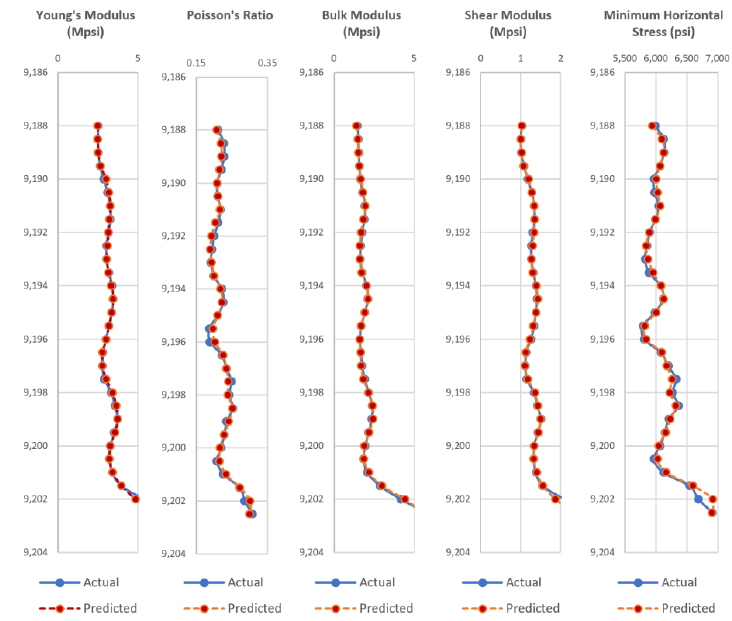
Figure A1. Actual and predicted geomechanical properties along with depth (feet) for test well 1 in Burke County for the Upper Bakken Shale. Energies 2018 , 11 , x FOR PEER REVIEW